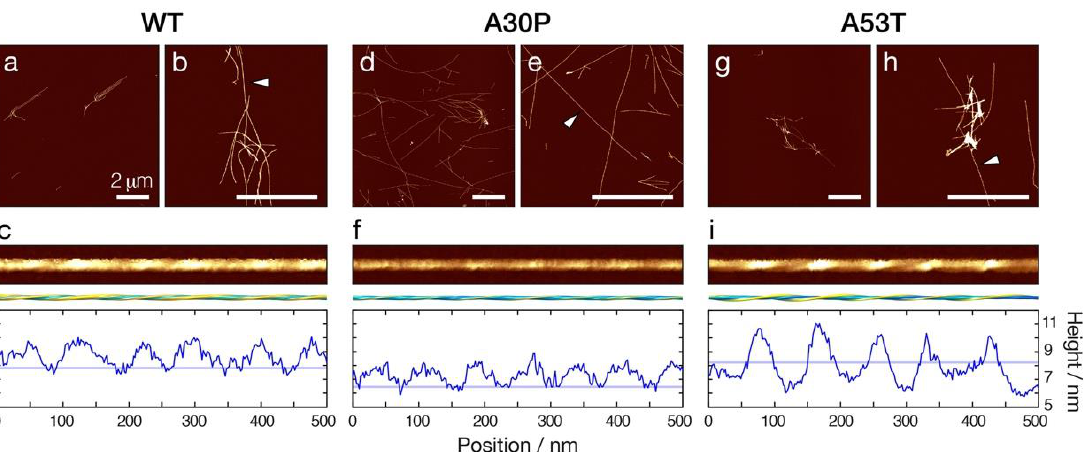
Figure 1. WT, A30P, and A53T α-synuclein amyloid fibrils formed in vitro display different fibril morphologies. AFM images of amyloid fibrils samples formed from WT ( a , b ), A30P ( d , e ) and A53T ( g , h ) α-synuclein. All three variants of α-synuclein amyloid fibrils were formed at 50 µM monomer equivalent concentration by gentle shaking at 180 rpm, 37 °C, for at least 14 days. AFM images representing 10 × 10 µm ( a , d , g ) or 4 × 4 µm ( b , e , h ) surface areas are shown with the scale bars indicating 2 µm. The white arrowheads in panels ( b , e ) and ( h ) indicate individual fibrils that are further magnified and shown in panels ( c , f , i ), respectively. In panels ( c , f , i ), the digitally straightened fibril images are shown together with 3D-reconstructed surface envelope models, their central-line height profiles (blue lines) and the population average height (pale blue lines) to demonstrate differences in fibril morphology.